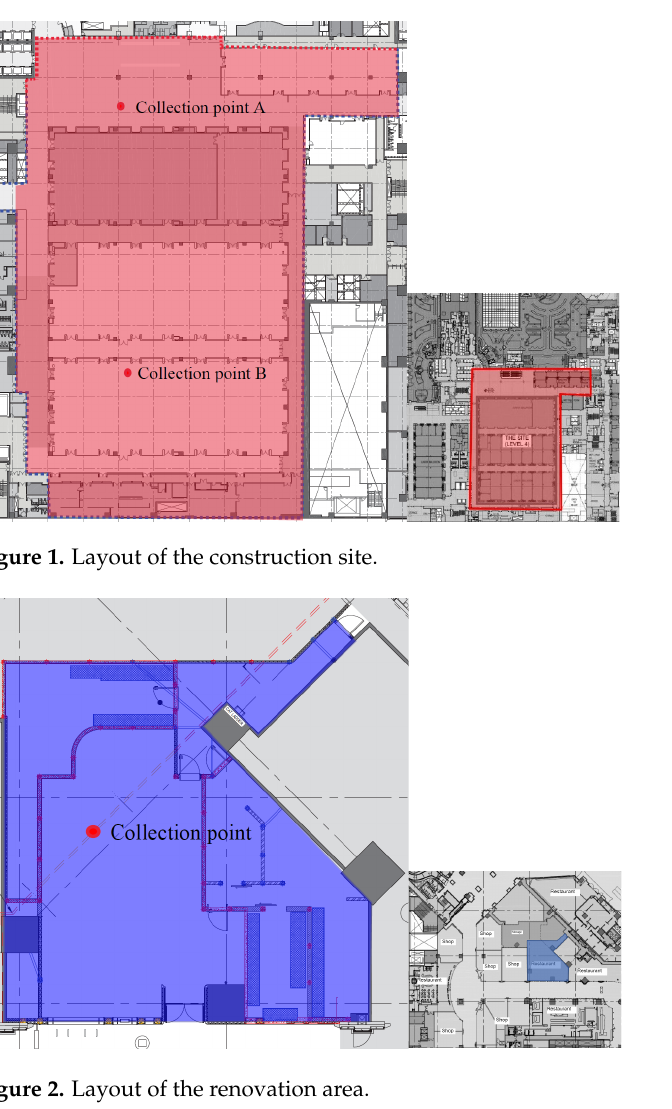
Figure 1. Layout of the construction site .